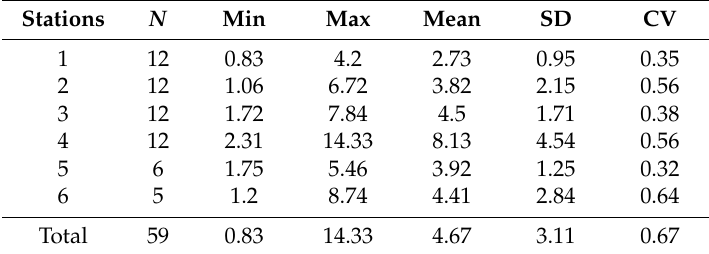
Table 2. Chl- a concentration ( µ g/L) descriptive